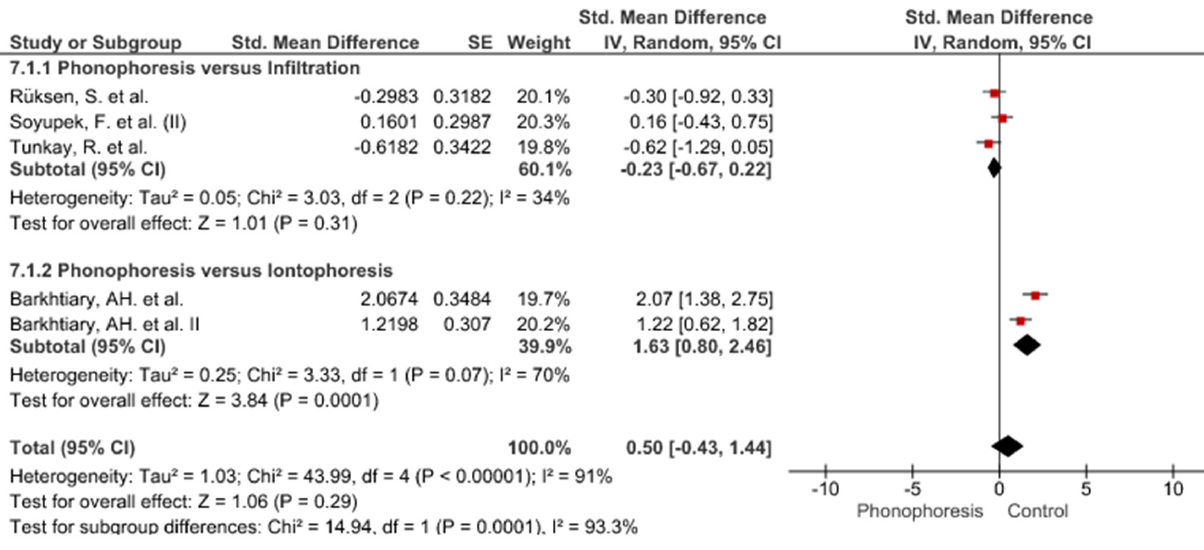
Figure 8. Phonophoresis for Grip strength.